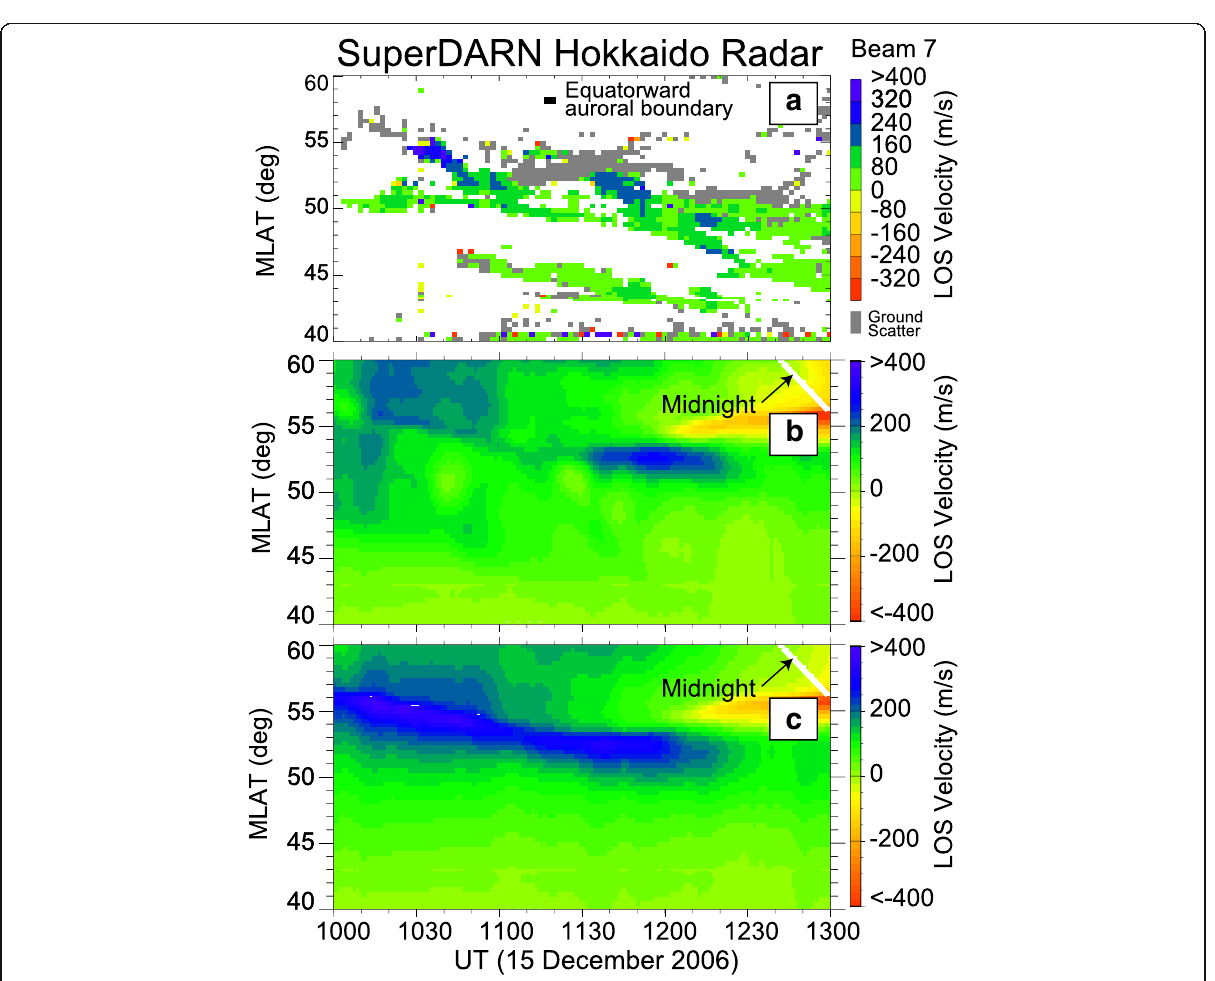
Fig. 14 Range-Time-Parameter plots of the Doppler velocities observed by beam 7 of the Hokkaido East radar ( a ) and calculated using the CRCM numerical simulation with the plasma sheet boundary conditions determined by the LANL particle data ( b ) and with fixed boundary condition ( c ). Reproduced from Fig. 5 of Ebihara et al.